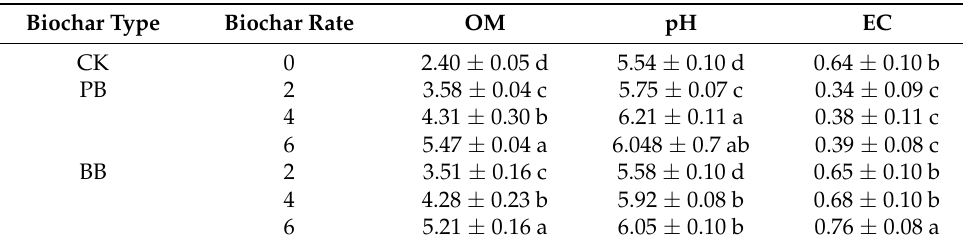
Table 2. Effect of biochar application on soil organic matter (%), soil pH (1:2.5), and electrical conductivity (EC, dSm − 1 ).